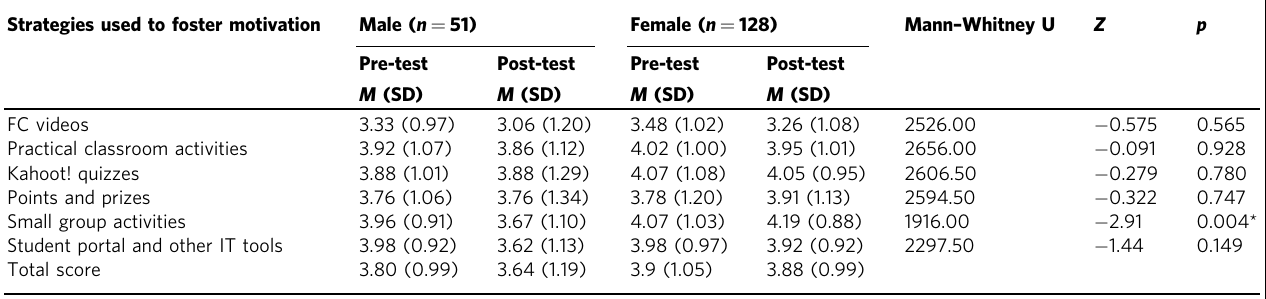
Table 3 Descriptive statistics for the variables referring to the evaluation of the strategies used to foster students ’ motivation in this approach during the COVID-19 pandemic according to the gender of the participants.